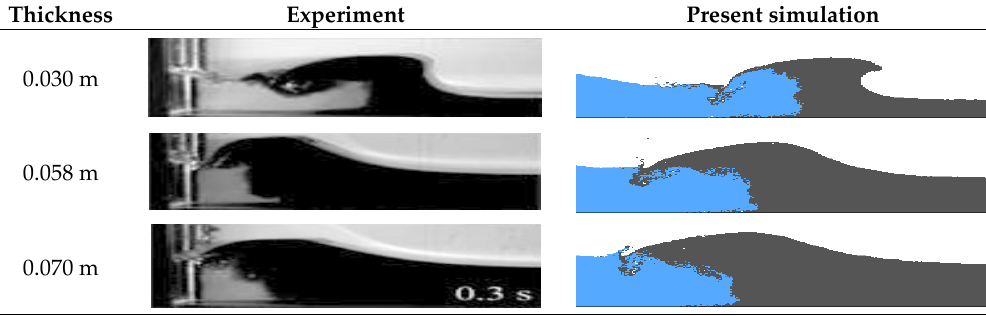
Figure 7. Result comparisons between the experiment and numerical simulation for a broken dam with 0.15-m depth of soil bed.